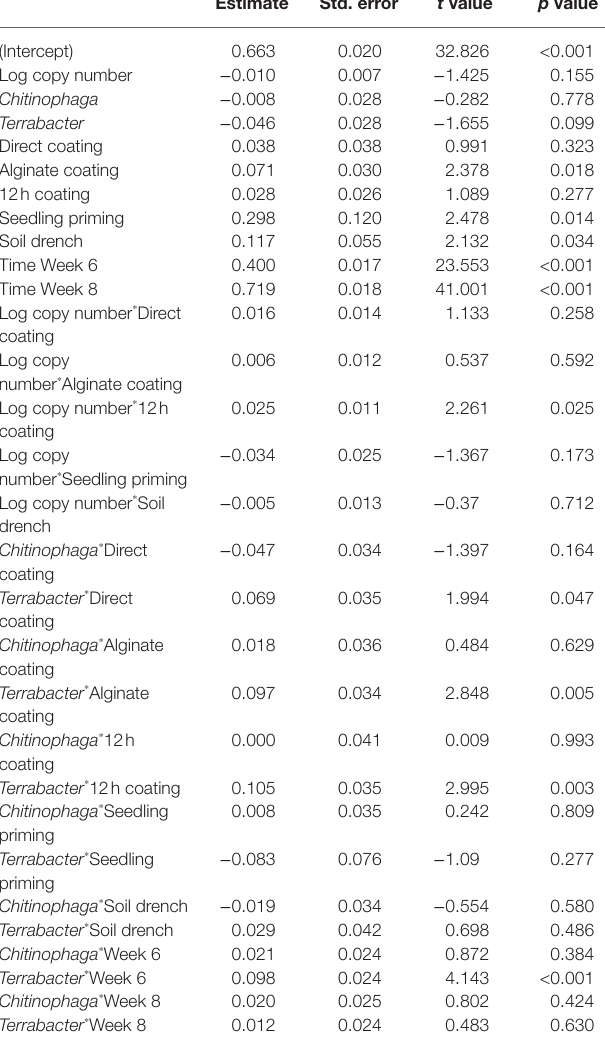
TABLE 3 | Linear model testing the effect of the degree of colonization (log copy number), bacterial strain, inoculation method, and their interactions on sorghum root dry